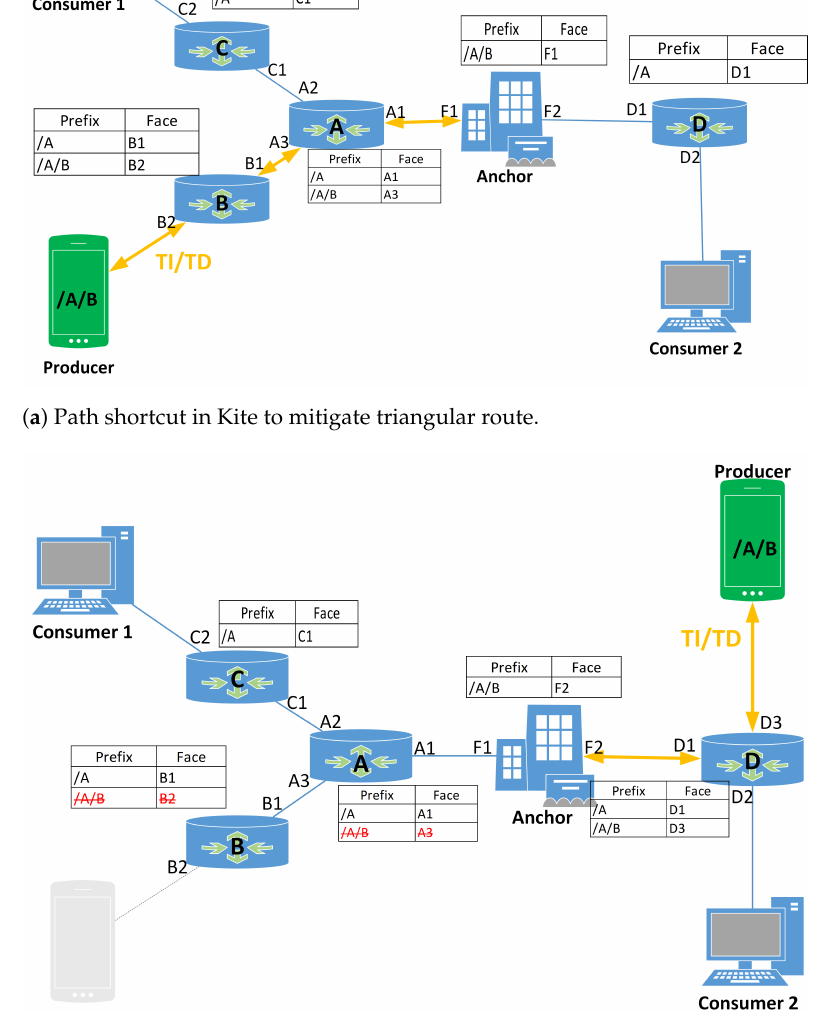
Figure 4. Example Kite